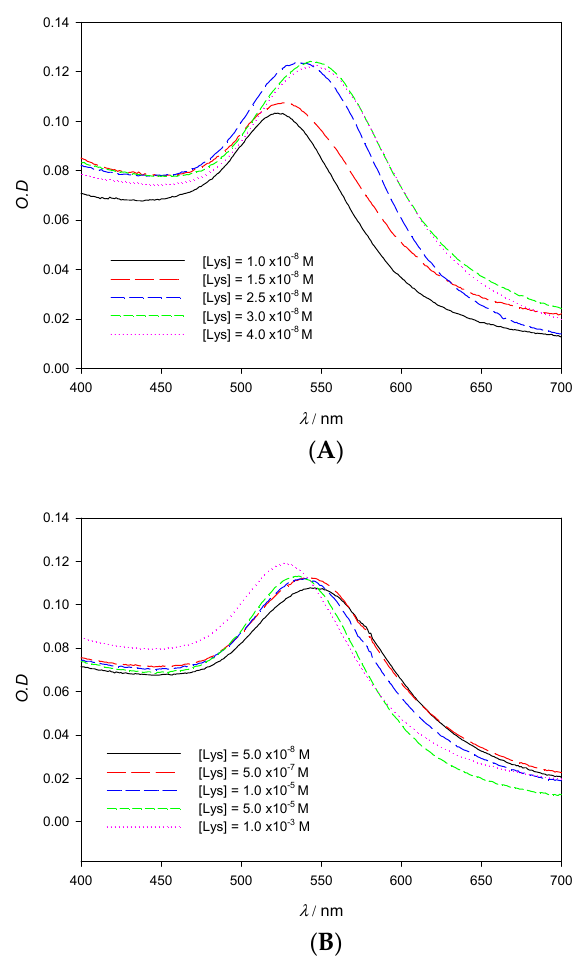
Figure 4. Experimental spectra of 10 nm AuNPs solutions on the visible region showing the red ( A ) and blue ( B ) shift in function of the Lys concentration. [AuNPs] = 8.22 × 10 − 10 M.